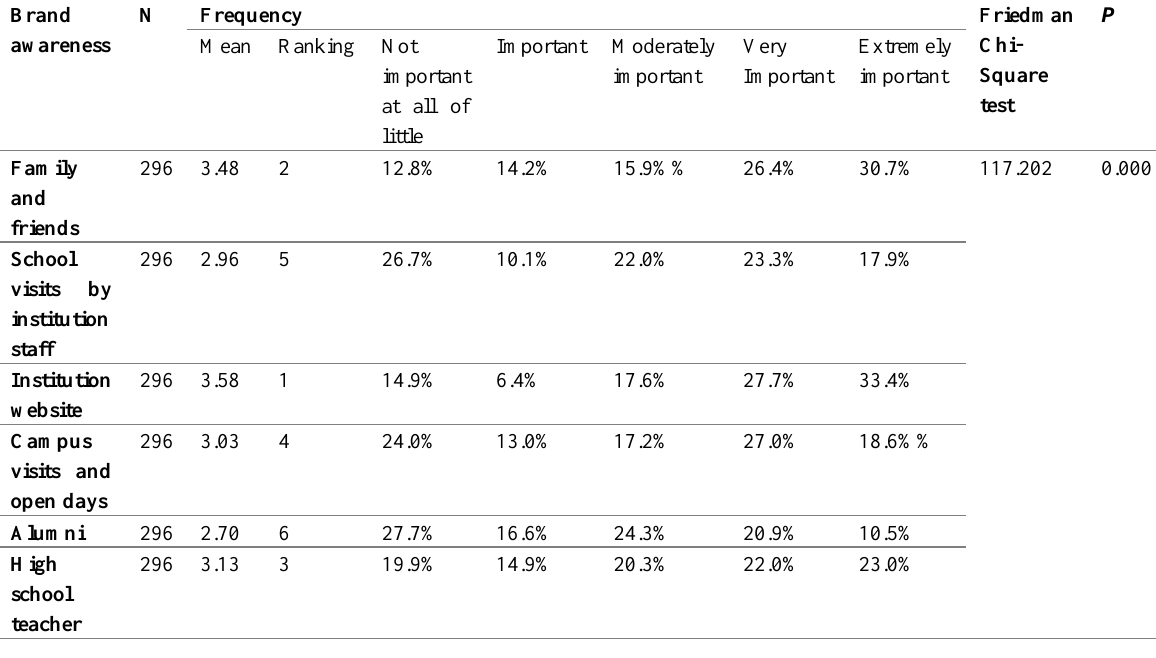
Table 6: DUT ranking of the important brand awareness attributes